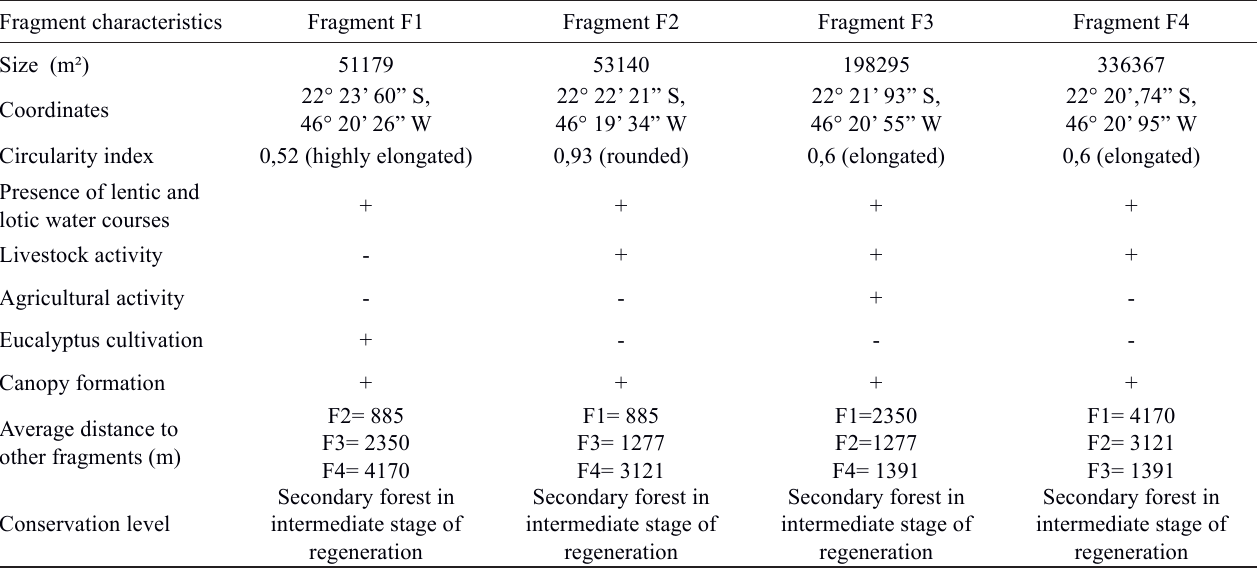
Table 1 . Different ecological characteristics regarding size and pastoral agricultural activities in the forest fragments (F1, F2, F3, and F4) in which the social wasps’ communities were evaluated, in the south of the state of Minas Gerais, in the Southeast region of Brazil. Fragment